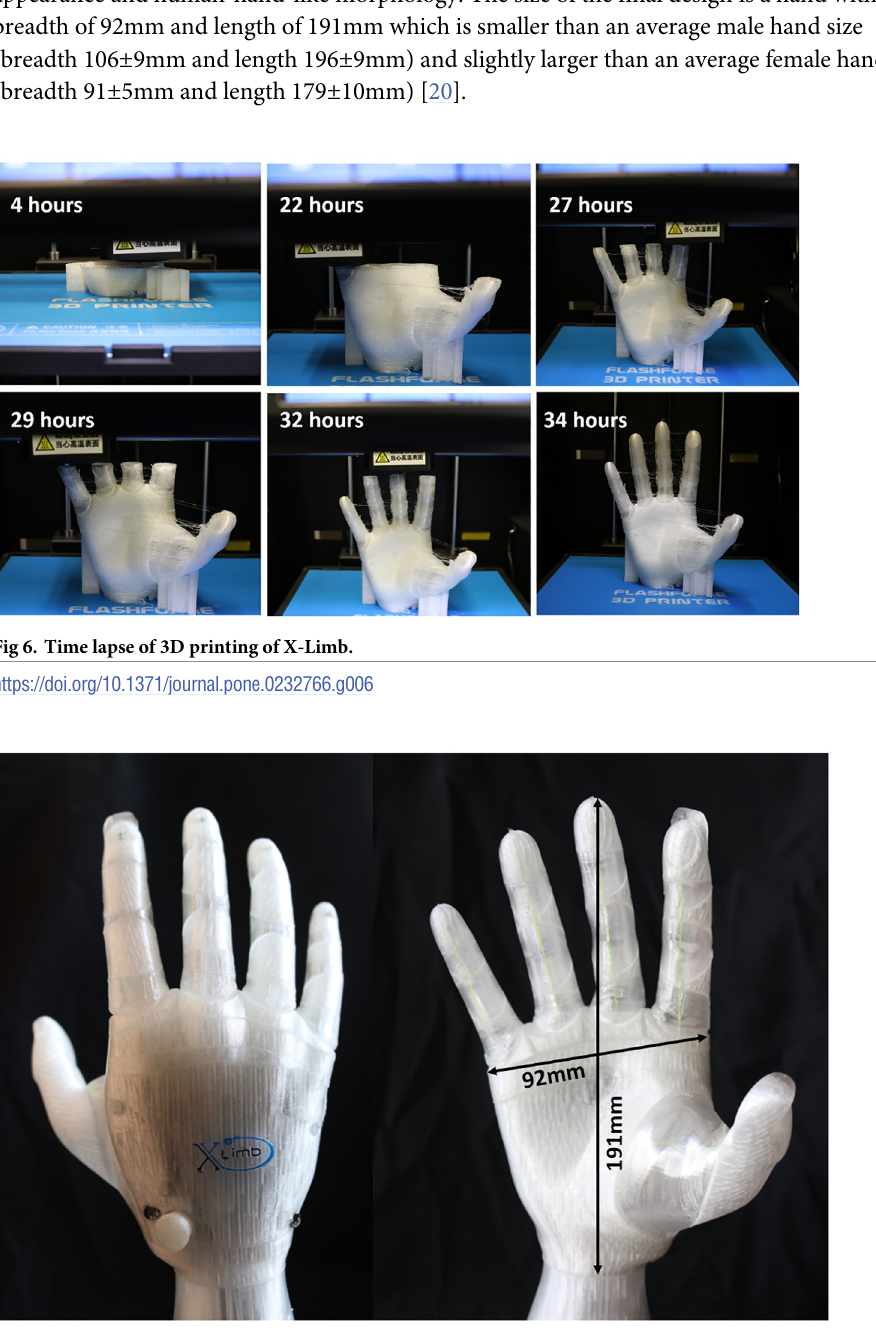
Fig 7. X-Limb appearance and